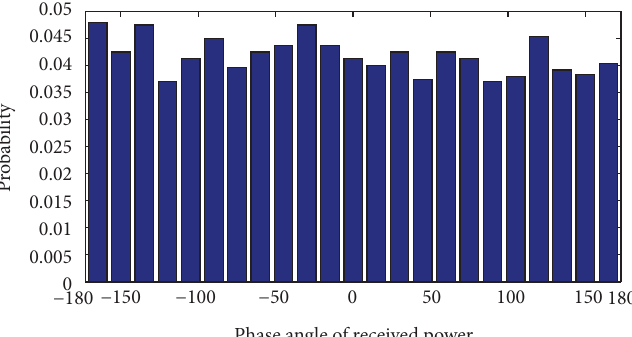
Figure 7: The phase angle of received power.